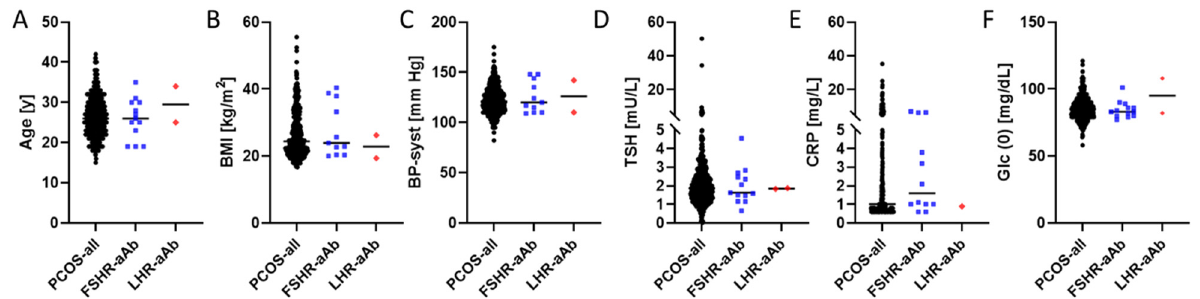
Figure 3. Comparison of anthropometric and clinical parameters of PCOS patients in relation to autoimmunity to the human FSHR or LHR. Patients were compared in terms of ( A ) age, ( B ) body mass index, and ( C ) systolic blood pressure, as well as ( D ) TSH, ( E ) C-reactive protein, and ( F ) fasted glucose concentrations. No pattern of consistent differences was observed in this analysis.